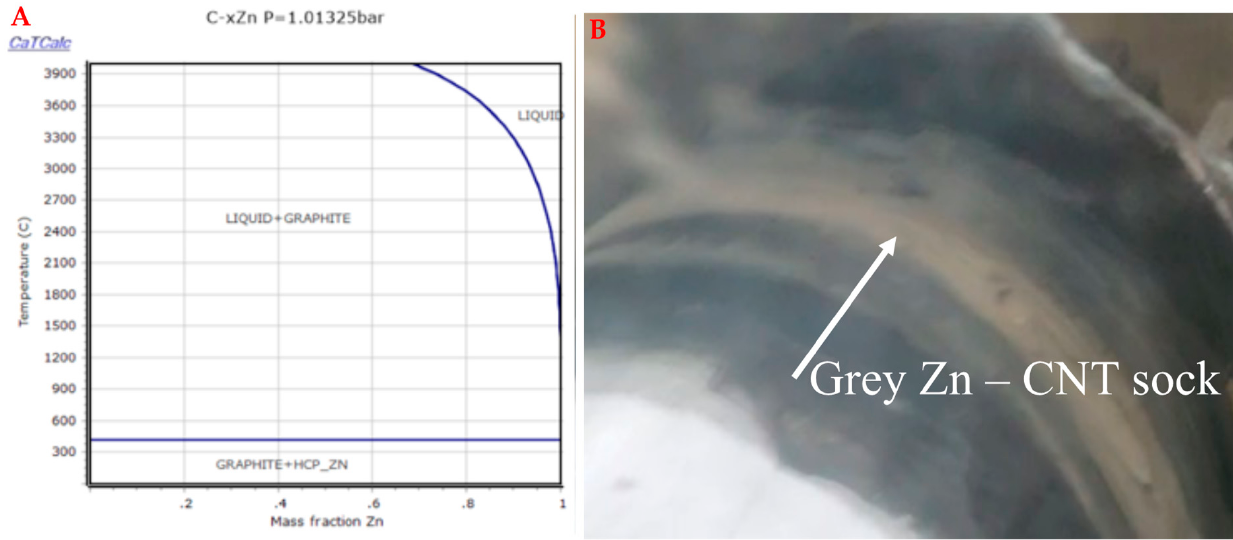
Figure 5. Incorporating nanoparticles into the synthesis process. ( A ) Phase diagram to describe mixing Zn with C. Zn NPs (60 nm diameter) melt, vaporize, and are deposited on the CNT sheet or inside the CNT. ( B ) CNT sock winding onto the take-up drum to form a CNT sheet with Zn NPs only in the center (grey-colored strip). The nanoparticles can be functionally graded throughout the CNT fabric.